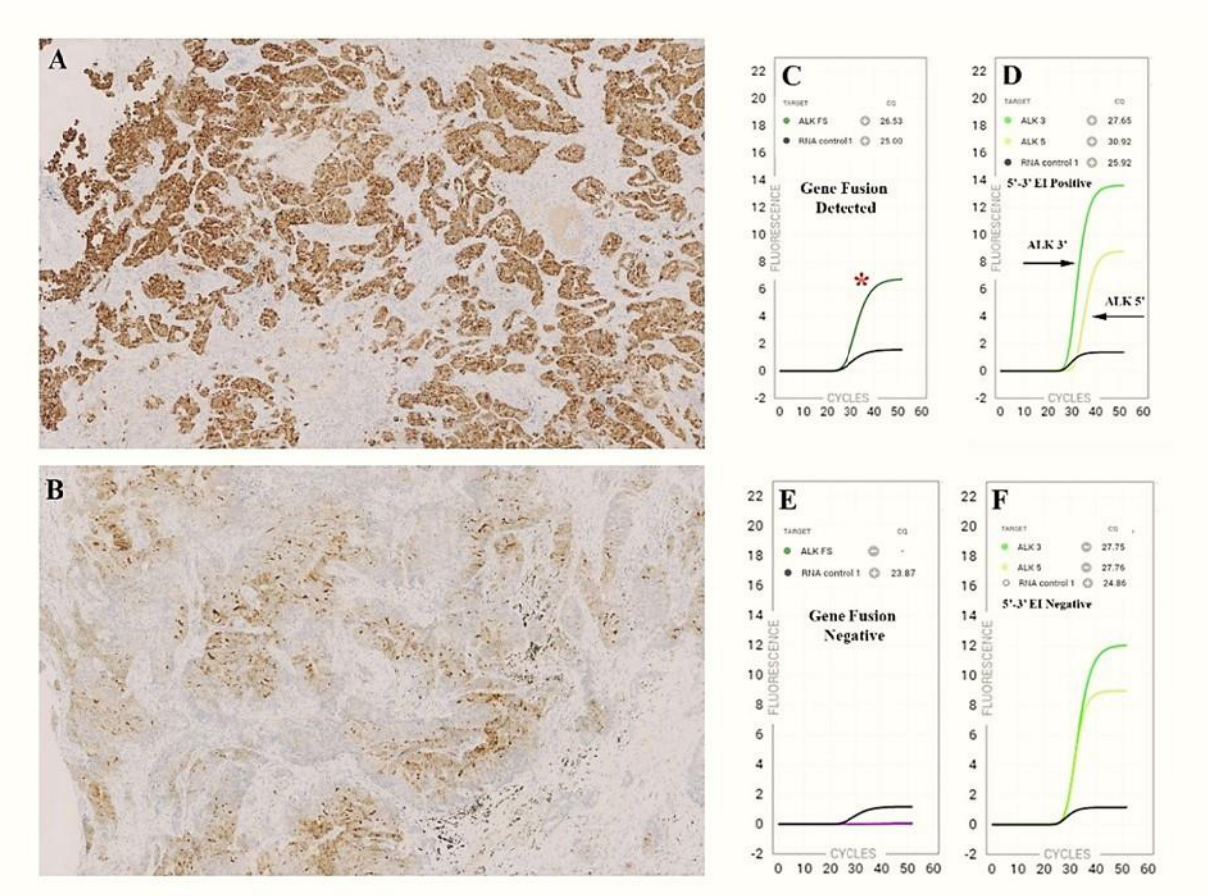
Figure 1. The Idylla TM GeneFusion assay in comparison to IHC staining. ( A ) ADC presenting the membrane staining characteristics resulting from the overexpression of a rearranged ALK protein (100% positive neoplastic cells); ( B ) LCNE carcinoma exhibiting moderate and patchy staining in 50% of neoplastic cells; ( C , D ) Idylla TM GeneFusion plots showing ALK fusion-specific amplicon (red asterisk) and 3 (cid:48) /5 (cid:48) EI (green curves); ( E , F ) the ALK-FS probes failed to amplify and 3 (cid:48) /5 (cid:48) EI is not